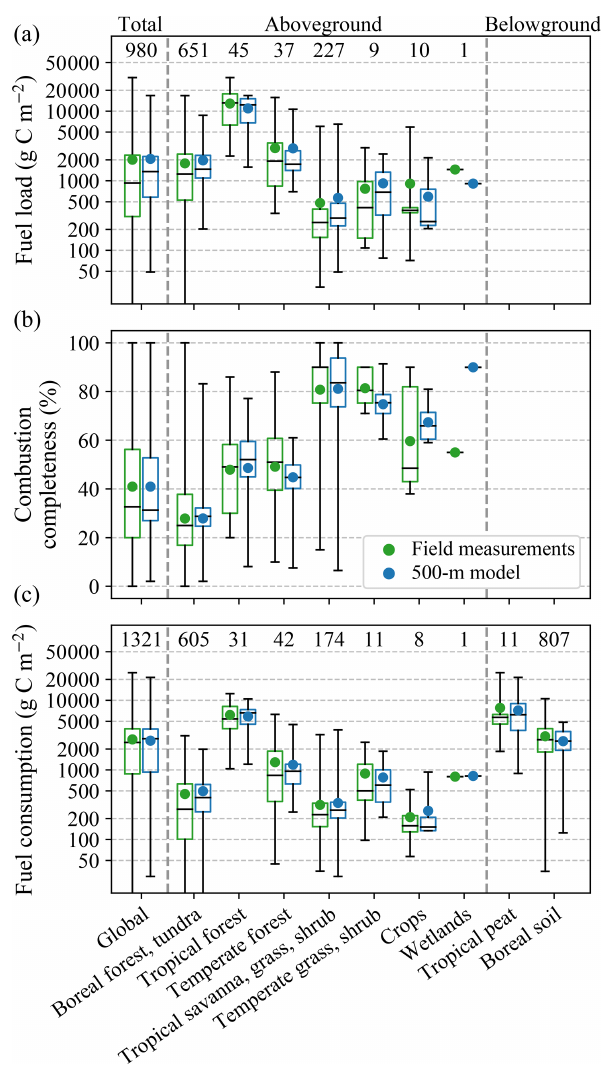
Figure 3. Comparison of field measurements of (a) fuel load, (b) combustion completeness (CC), and (c) fuel consumption versus model estimates for all field data (Table 2), grouped per biome class. The number of measurement records included is given above each box plot. Aboveground and belowground fuel classes are grouped separately. Belowground fuel classes (tropical peat and boreal soil) are only reported for fuel consumption measurements because our model relied on static SOC density maps for calculating soil fire emissions (see Sect. 2.1.3). Global values are for the total mea- sured fuel available, which in the case of (a) and (b) are above- ground values and for (c) are the sum of above- and belowground for each measurement record. Note that the number of fuel consump- tion measurements for the individual biomes does not sum to the global total number of sites (1321) because measurement records with both aboveground and belowground values are being counted as one record in the global class. The y axes of panels (a) and (c) are logarithmic, and the y axis of panel (b) is linear. Box plot whiskers give the range of